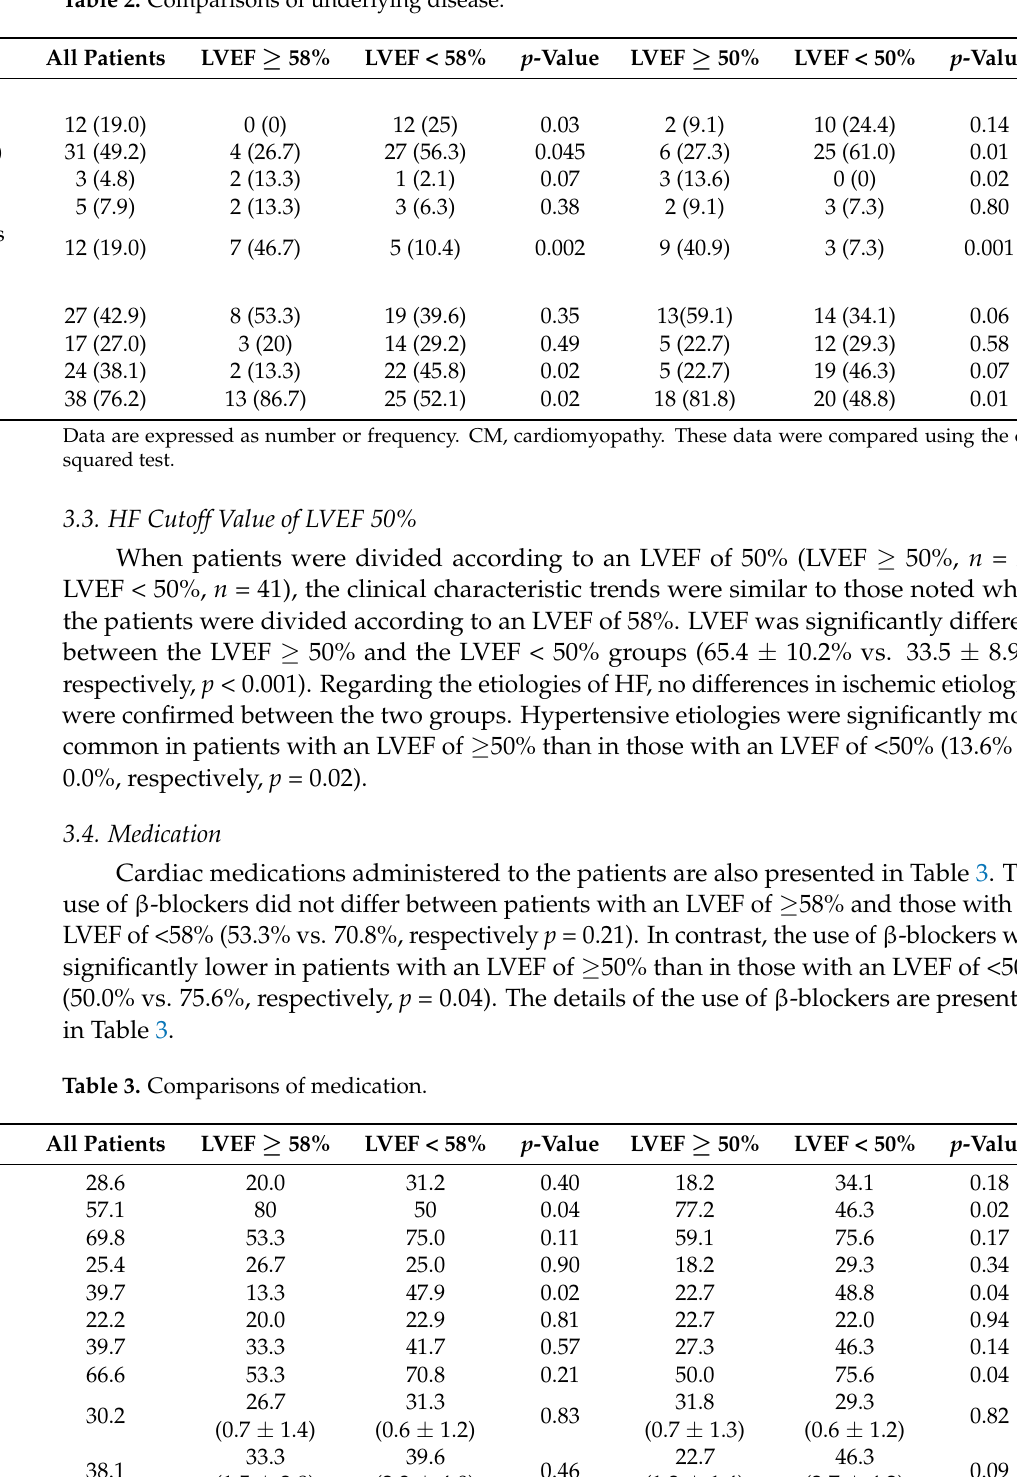
channel blocker. The frequency of medications used between the two groups was compared using the chi-squared test. Parentheses data were compared using an unpaired Student’s t